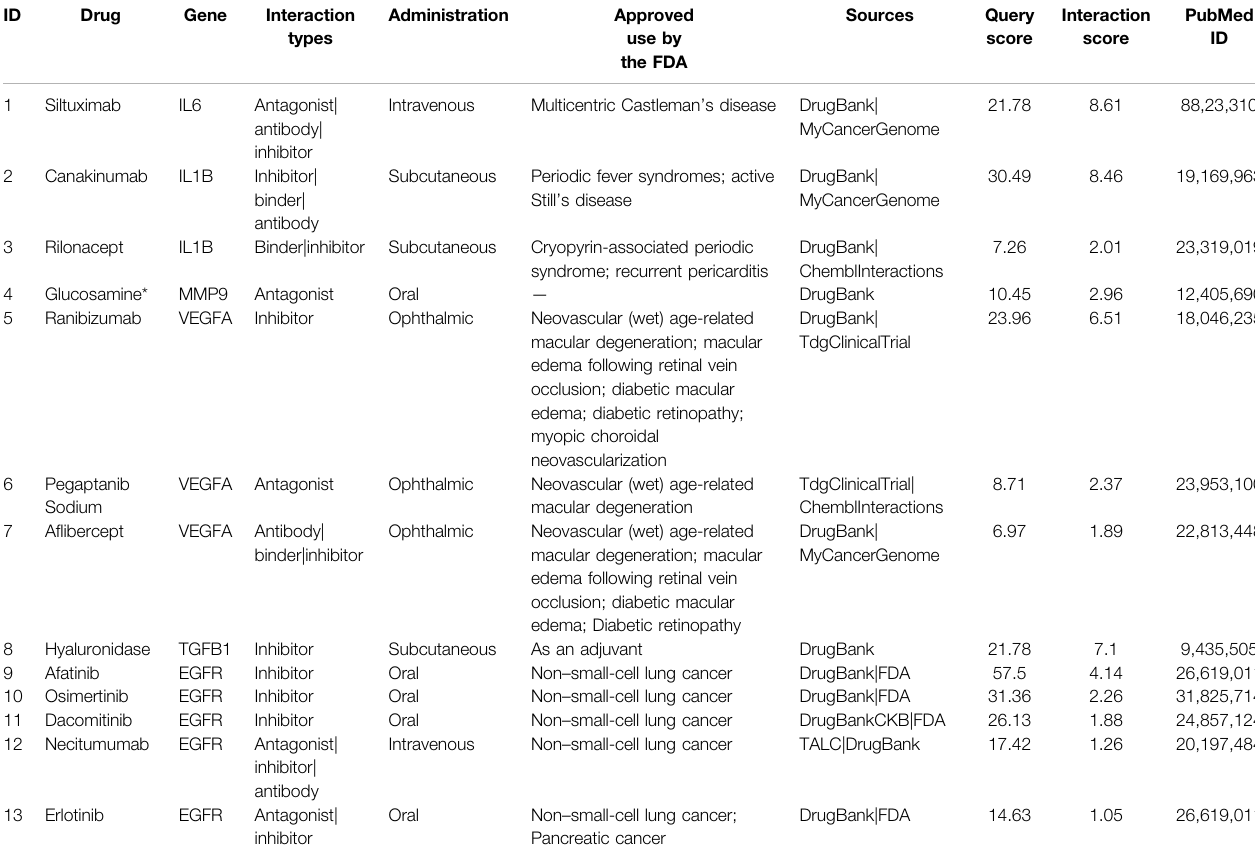
TABLE 1 | The available drugs that can target six candidate